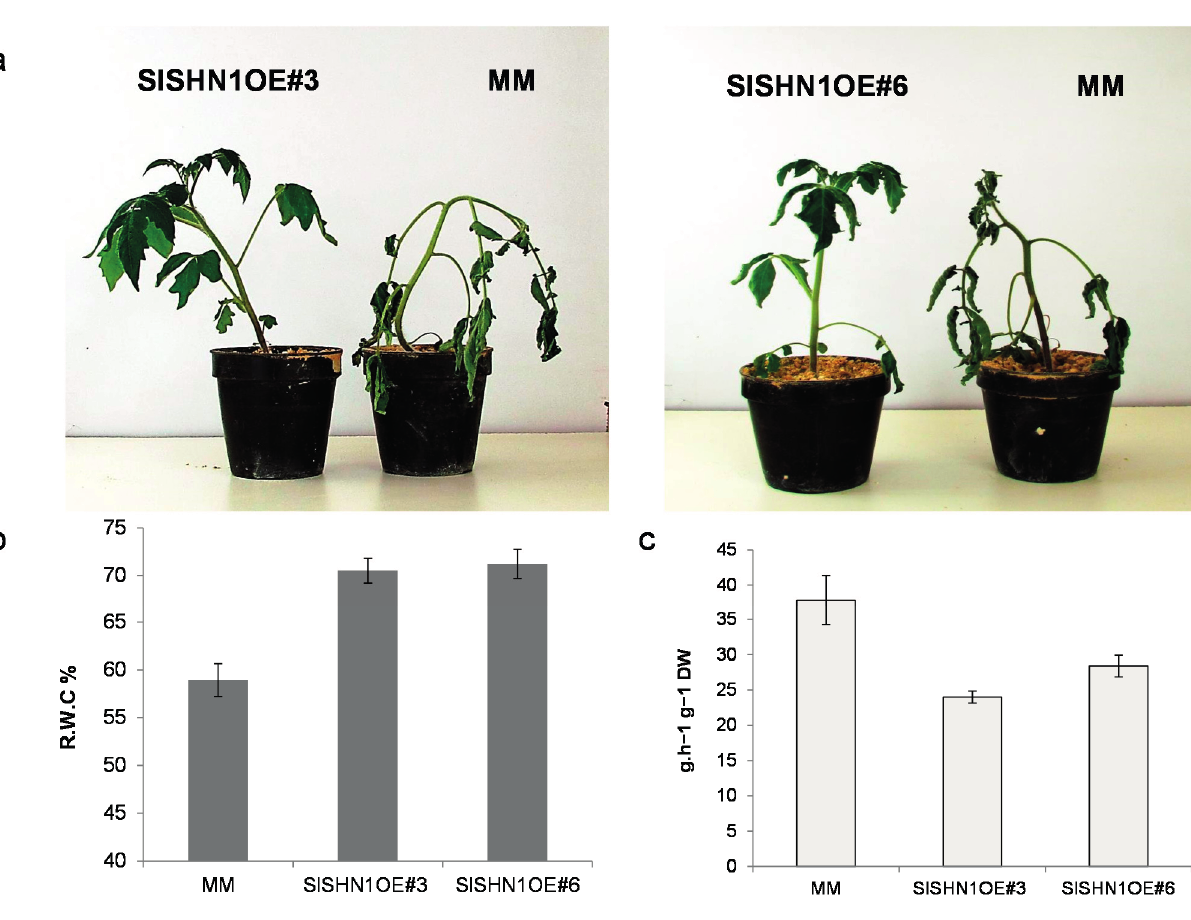
Figure 6. ( a ) Growth performance of tomato plants of two transgenic lines over-expressing SlSHN1 ( SlSHN1OE#3 and SlSHN1OE#6 ) and wild type (MM) after 21 days of water withholding; ( b ) R.W.C. in leaves of two transgenic lines over-expressing SlSHN1 ( SlSHN1OE#3 and SlSHN1OE#6 ) and wild type (MM) after 21 days of water withholding. Values are the means ± S.E. of 5 plants; ( c ) Water loss as measured by decrease in fresh weight after 2 h in detached leaves from two transgenic lines over-expressing SlSHN1 ( SlSHN1OE#3 and SlHN1OE#6 ) and wild type (MM). Values are the means ± S.E. of 5